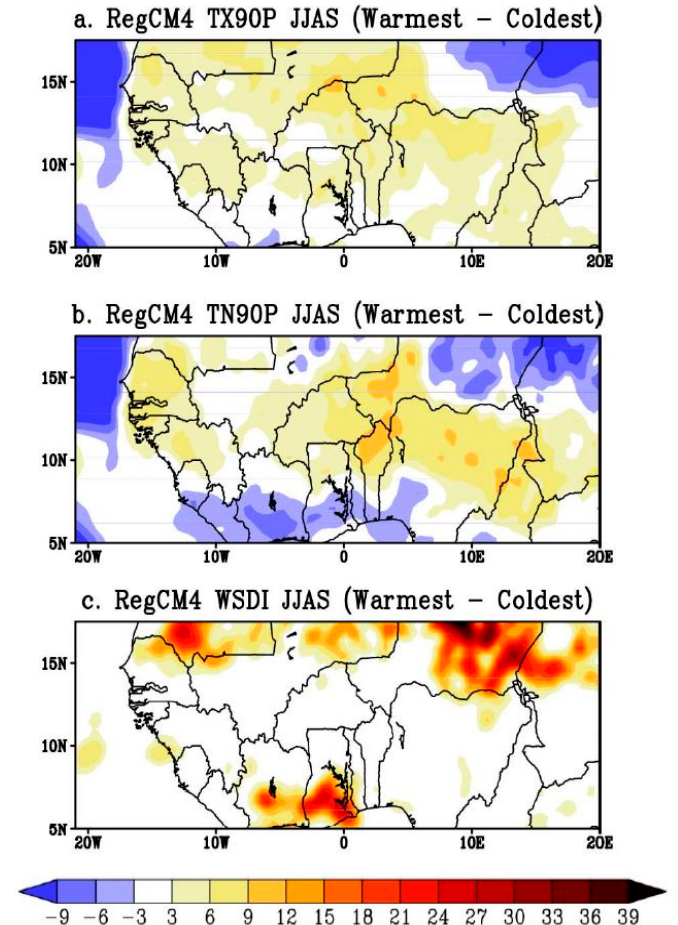
Figure 7. Climate indices over West Africa from the RegCM4 model (Average of the warmest years—Average of the coldest years) for JJAS mean; ( a ) the very warm days (TX90P), ( b ) the warm nights (TN90P), and ( c ) the warm spell days index (WSDI).